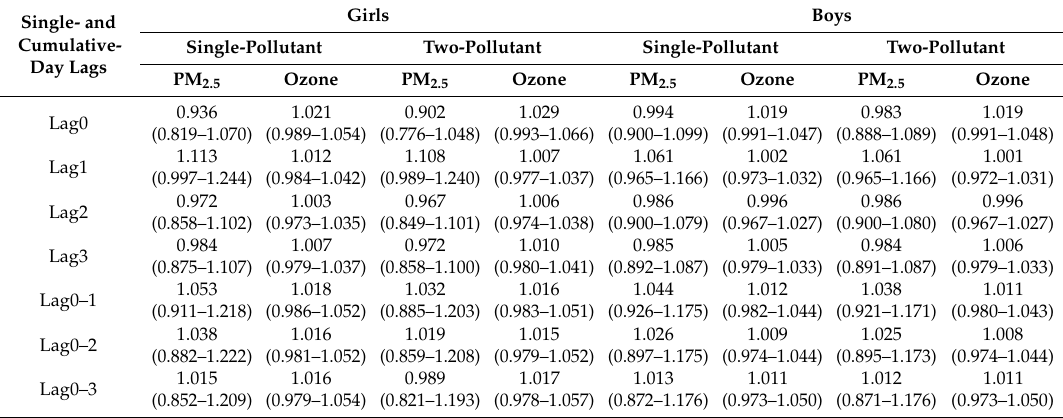
Table 5. Results of the conditional logistic regression analysis stratified by